Question: Compose a caption that would accompany this figure in a paper.
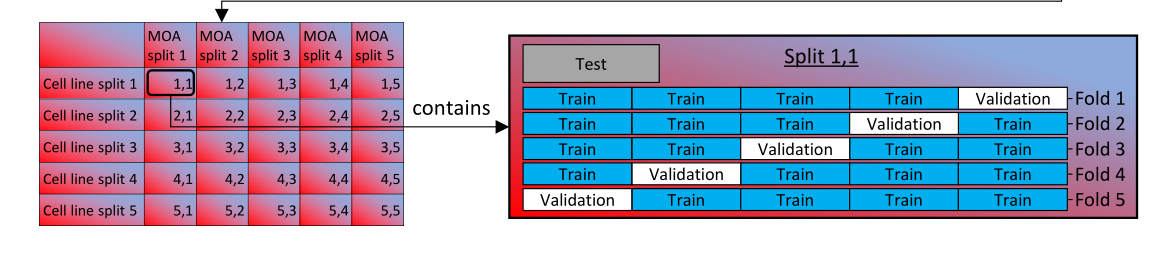
Answer: Data splitting regime. A) Splitting cell lines and MOAs into 5 cell line and 5 MOA splits using the CMap database  and compound MOA information from the Drug Repurposing Hub. Two tables are generated (with missing values imputed)  representing; i) mean MOA response across cell lines, with rows representing cell lines and feature columns containing gene  Z-scores for each MOA, and ii) mean cellular response to MOA treatments, with rows representing MOAs, and feature  columns containing gene Z-scores for each cell line. The 5 most diverse cell lines from table i are placed into a unique MOA  split, which are then filled in a round-robin manner assigning cell lines to splits which minimally increase all-to-all inter- split distances. The same protocol is applied to assign MOA splits using table ii. B) Combining cell line and MOA splits into  Leak Proof CMAP split objects creates 25 combined splits. These combined splits hold out their cell line split and MOA split  data in a te